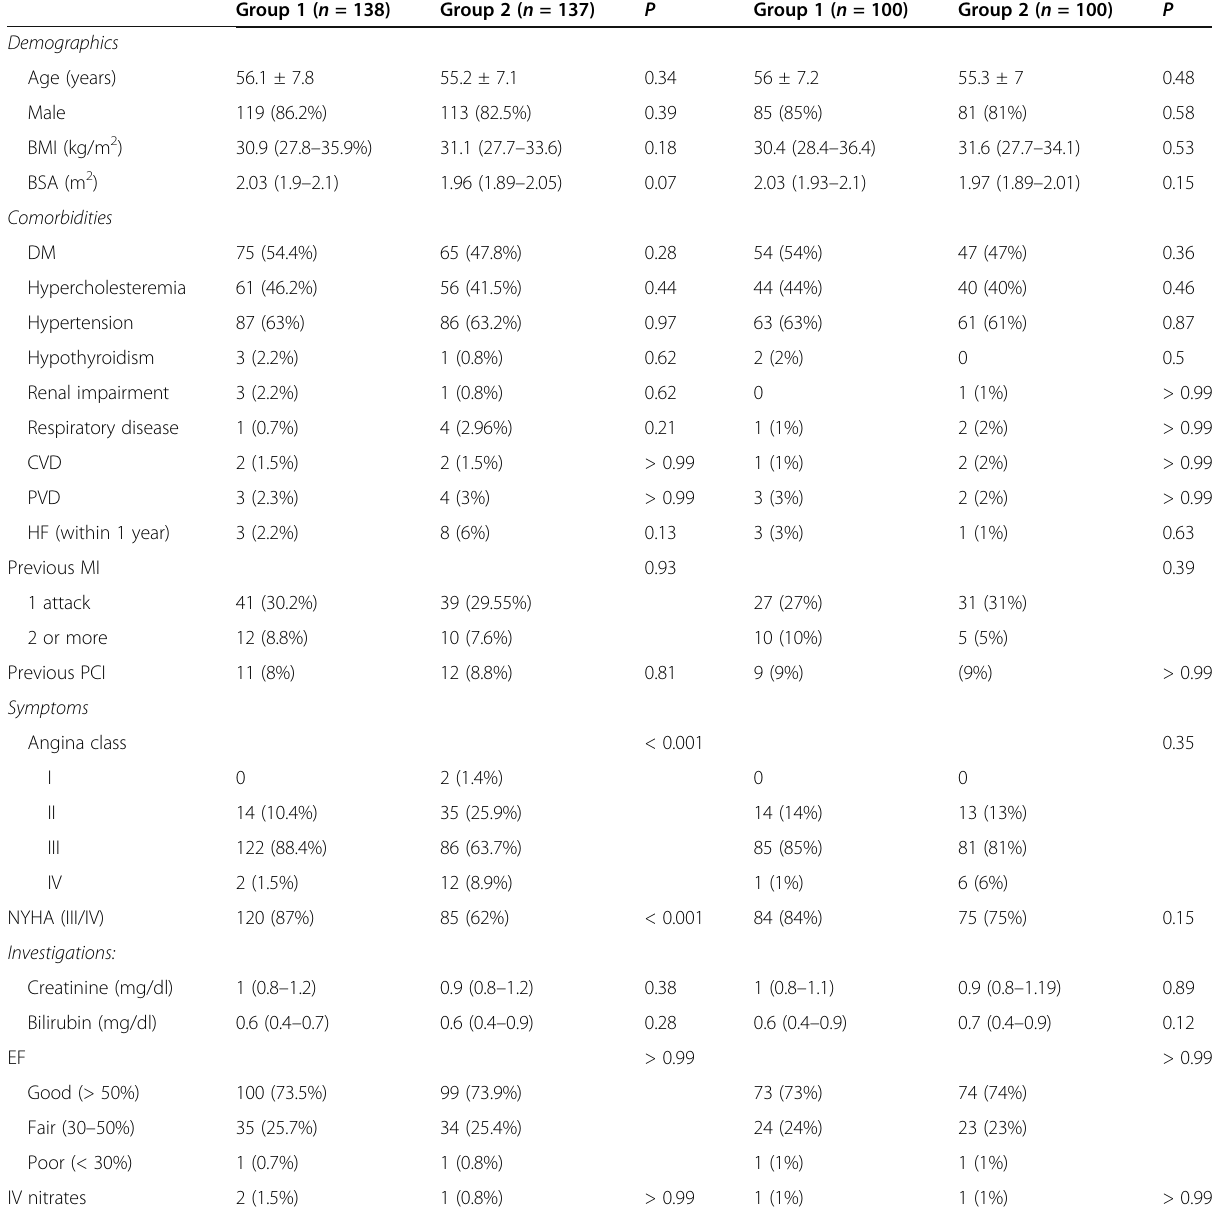
Table 1 Preoperative